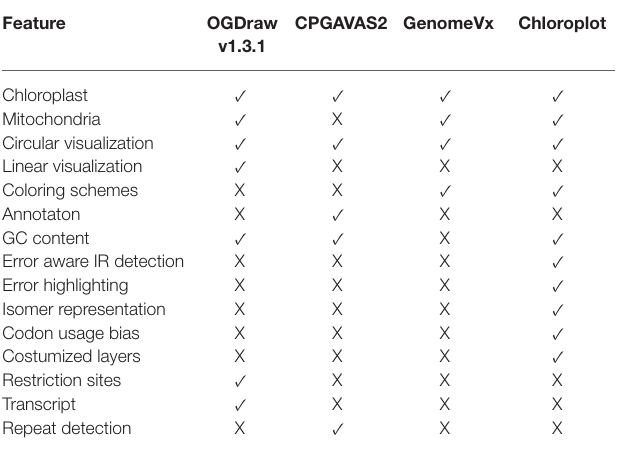
TABLE 1 | Comparison of the major features of various software developed for the visualization of organelle genomes. Feature OGDraw